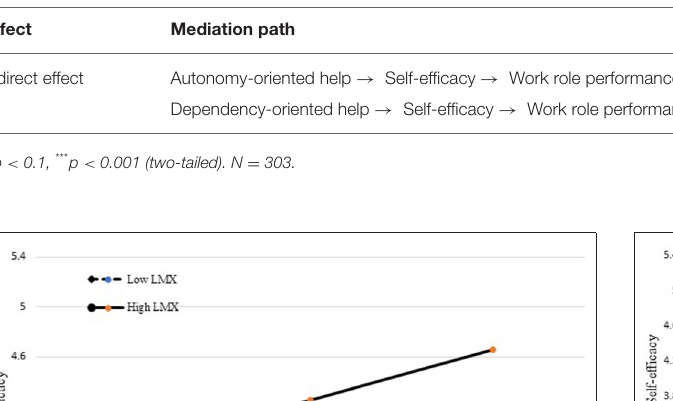
TABLE 3 | Indirect effects of leader helping on member work role performance.